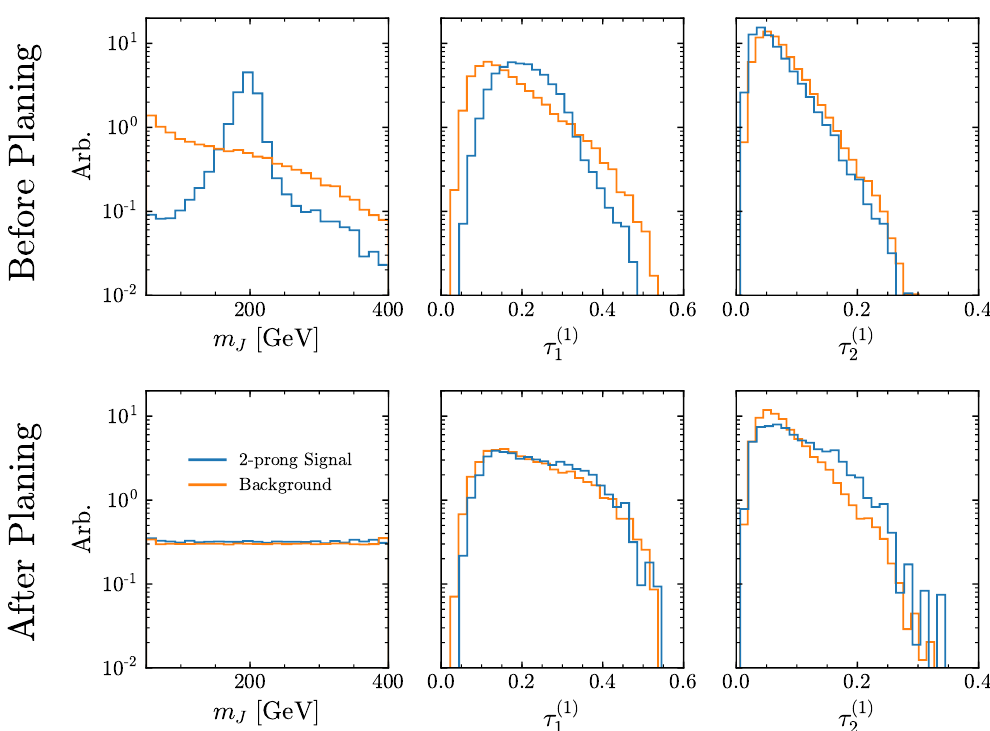
Figure 6: The upper and lower panels show distributions before and after planing away the jet mass, respectively. The left panels show the jet mass distribution for the 2-pronged signal and QCD background. By design, both distributions are (nearly) identical, and uniform across the entire mass range after planing. The center panels ( 1 ) , one of the input variables for the classifiers. Before planing, this variable show τ 1 has discriminating power, but that was correlated with the jet mass and got removed ( 1 ) by the planing process. The right panels show τ , which has more separation be- 2 tween signal and background after